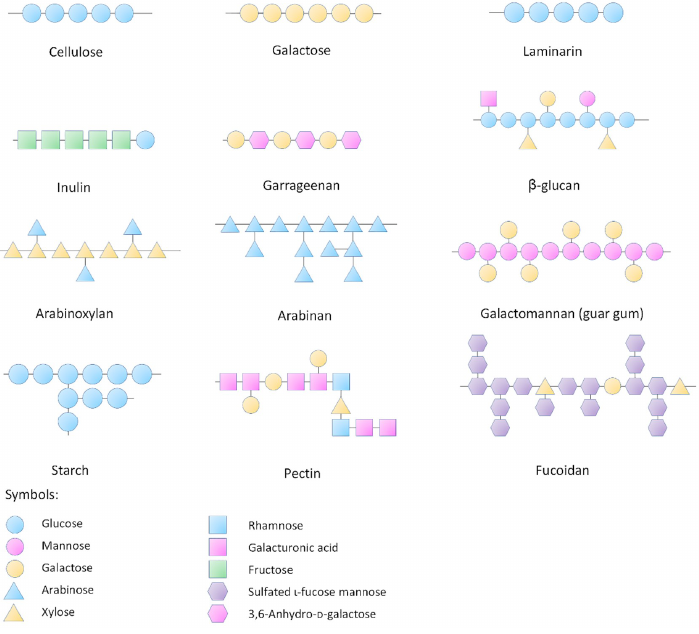
Figure 1. Structures of representative